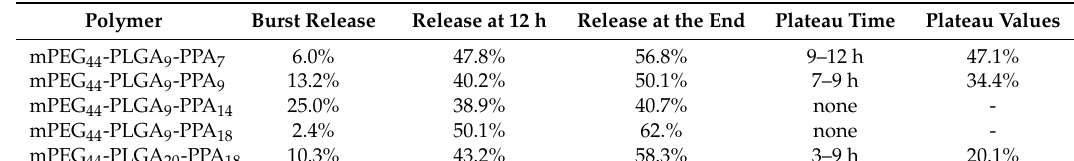
Table 6 in vitro drug release profiles of SFN loaded mPEG-PLGA-PAA micelles. Table 6. In vitro drug release profiles of SFN loaded mPEG-PLGA-PAA micelles.